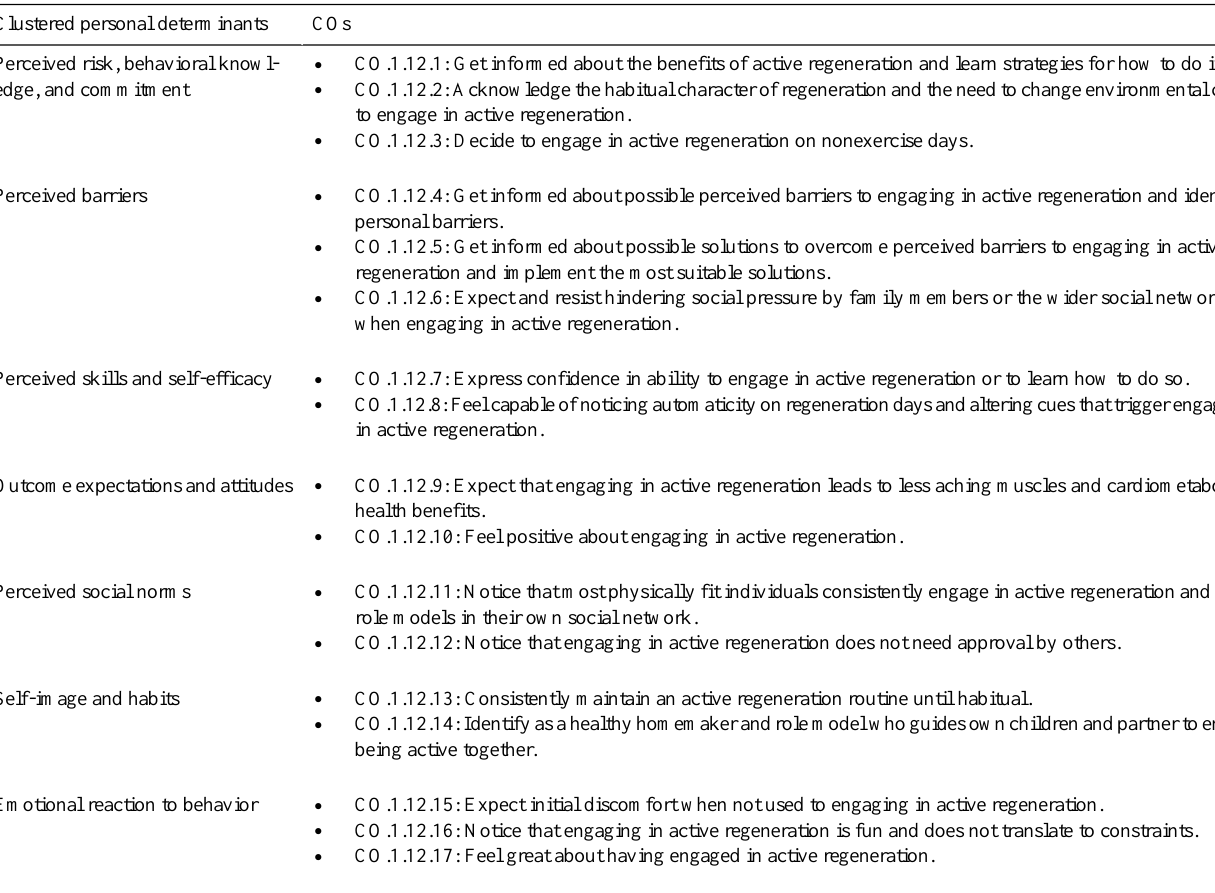
Table 1. Change objectives (COs) for performance objective 1.12: Engage in active regeneration on nonexercise